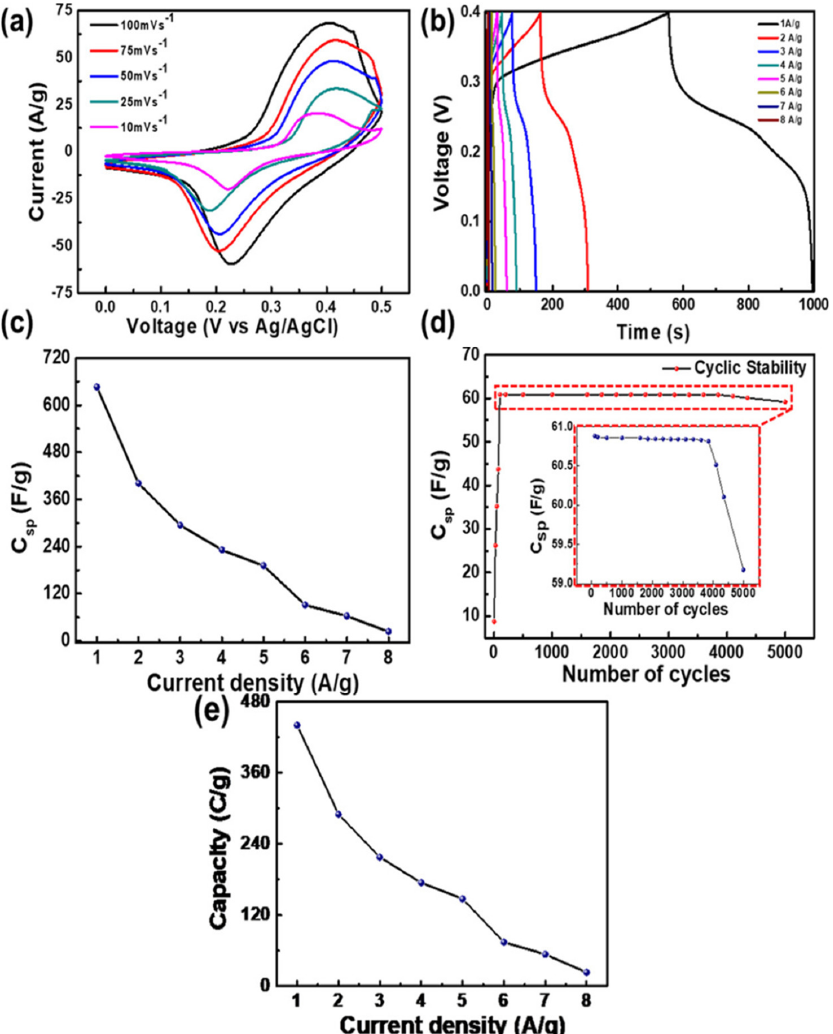
Figure 11. ( a ) CV, ( b ) GCD curves, ( c ) Cs vs. current density, ( d ) cyclic stability and ( e ) specific capacity vs. current density. Reproduced with permission from [24] Copyright (2020) American Chemical Society.